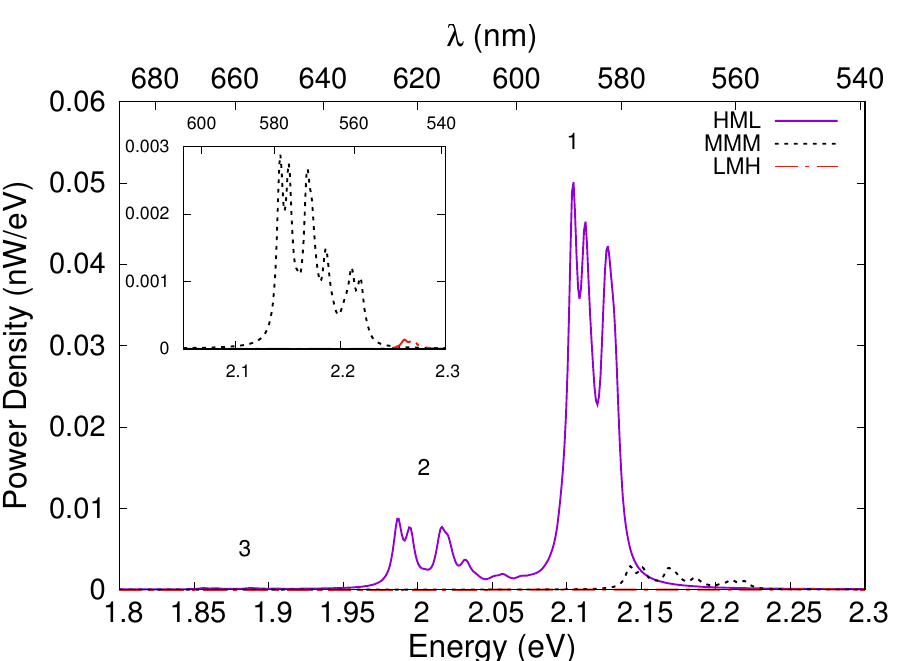
Figure 5. Spontaneous emission spectra for the HML, MMM, and LMH configurations. Inset: magnification of spontaneous emission spectra for the MMM and LMH